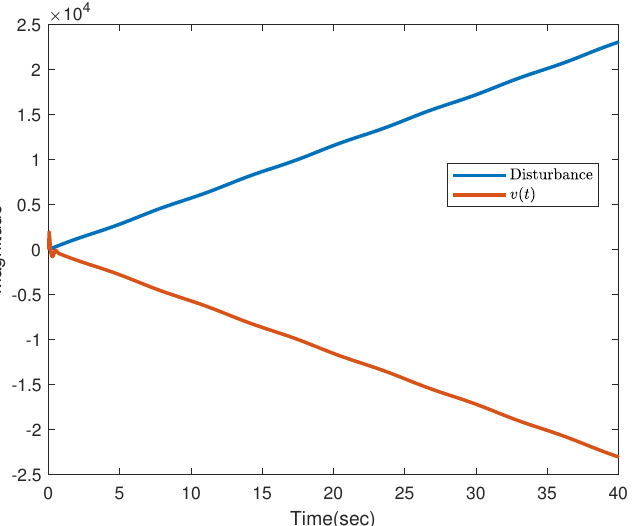
Figure 8. Time history of the compensator control input (22) v ( t ) , based on the estimates produced by the observer (16), against the disturbance ξ ( t ) = K 5 u q = 4024.14 ( 0.1 t + 0.001cos ( 10 t ))